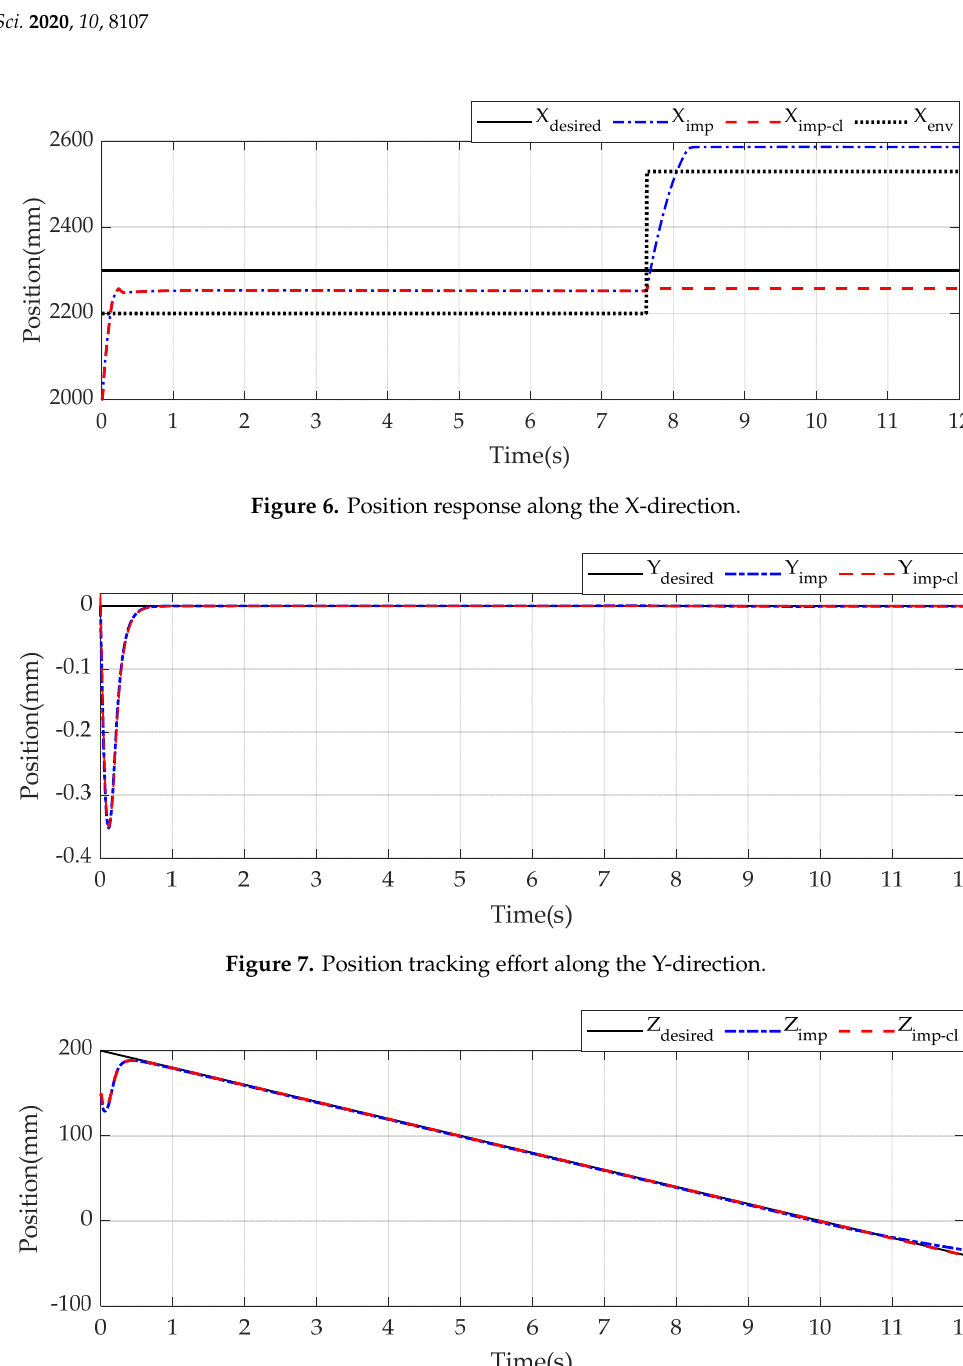
x Figure 5. Working scenario of the 6-DOF KIRO robot and prescribed expected trajectory after contact- loss happens. To mimic the contact-loss in two case studies, the environment profile is set as a step function as 